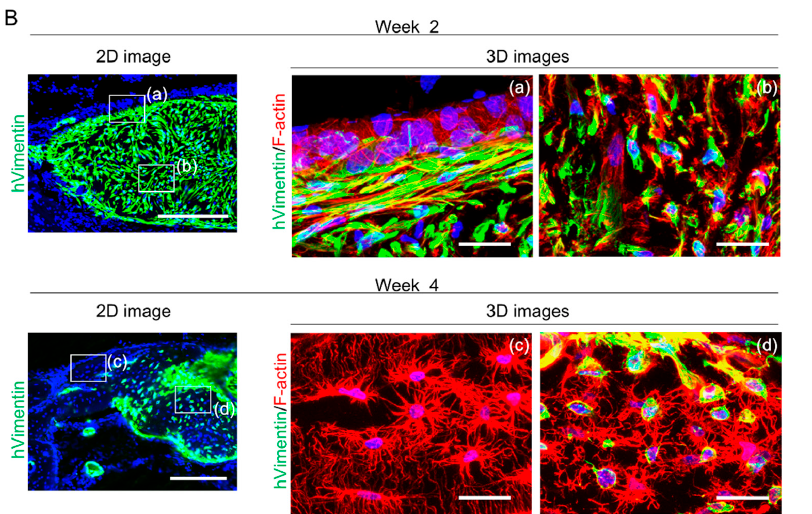
Figure 4. Transplantation of C-MSCs induces bone regeneration via direct and indirect osteogenesis in a SCID mouse calvarial defect model. ( A and B ) Animals were sacrificed at 1, 2, 4, and 8 weeks after surgery and the calvarial bones were fixed. Semi-serial sections were obtained and stained with AZAN and immunostained with anti-human COLI, anti-human OPN, and anti-human OCN antibodies, as indicated. Nuclei were counterstained with DAPI for immunostaining. Upper panels show lower magnifications. Bar = 200 µ m. Bottom panels are magnifications of the boxed regions. Bar = 50 µ m. ( B ) Animals were sacrificed at 2 and 4 weeks after surgery and the calvarial bones were fixed. Sections obtained using a cryostat were stained with anti-human vimentin antibody and phalloidin, as indicated. Nuclei were counterstained with DAPI. Left panels are lower magnification images showing vimentin and nuclei. Bar = 250 µ m. Right panels are 3D immunofluorescence images of the boxed region of lower magnification images labeled with (a), (b), (c), and (d) showing human vimentin (green), F-actin (red), and nuclei (blue). Bar = 25 µ m. The photographs are representative of four independent